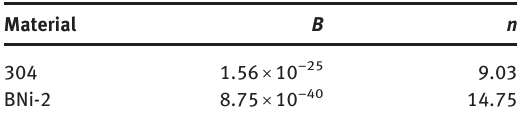
Table 2: Creep parameters for 304 and BNi-2 at 600°C [32]. Material